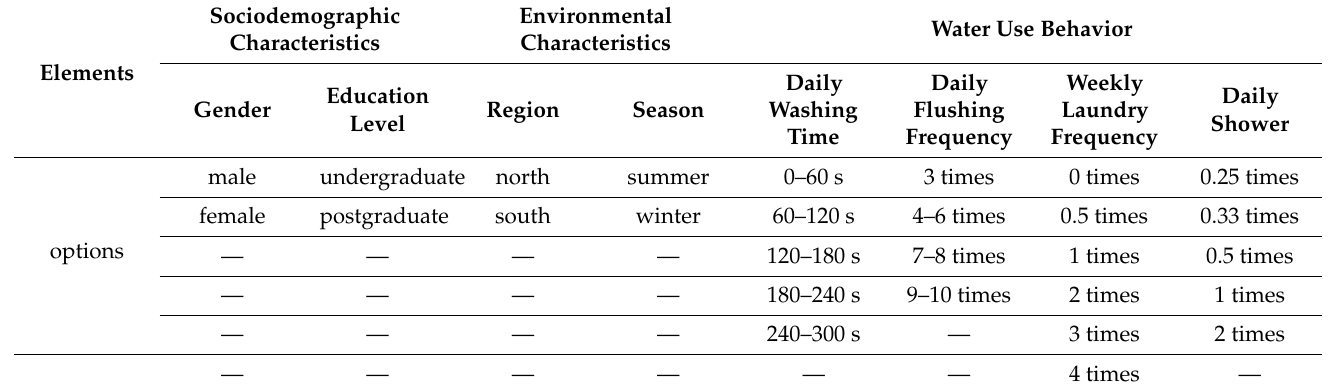
Table 1. Elements of questionnaire on water use behavior of college students.